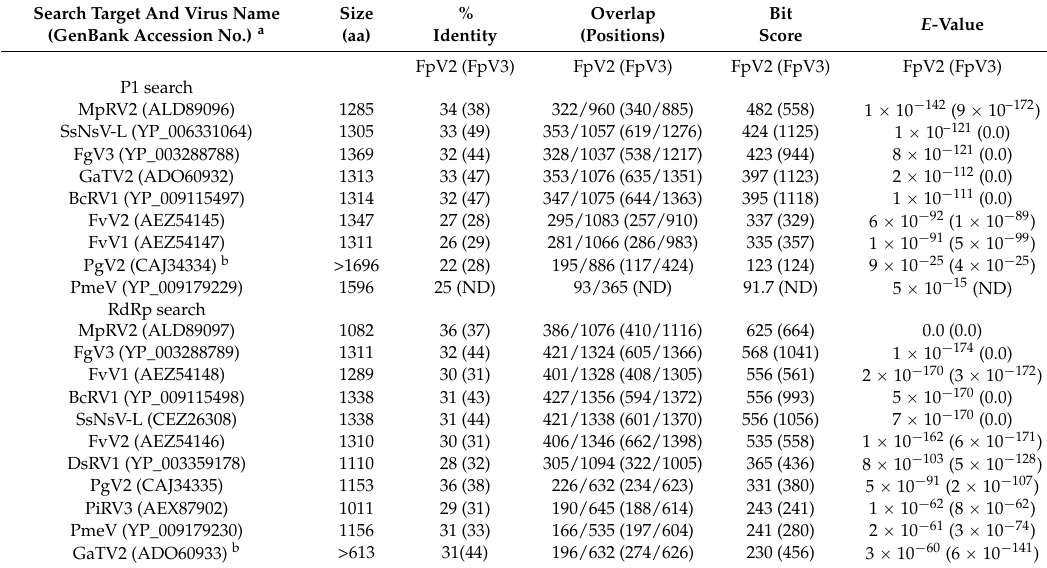
Table 2. BLASTP search results of ORF1-coded polypeptide P1 and ORF2-coded RNA-dependent RNA polymerase (RdRp) of FpV2 and